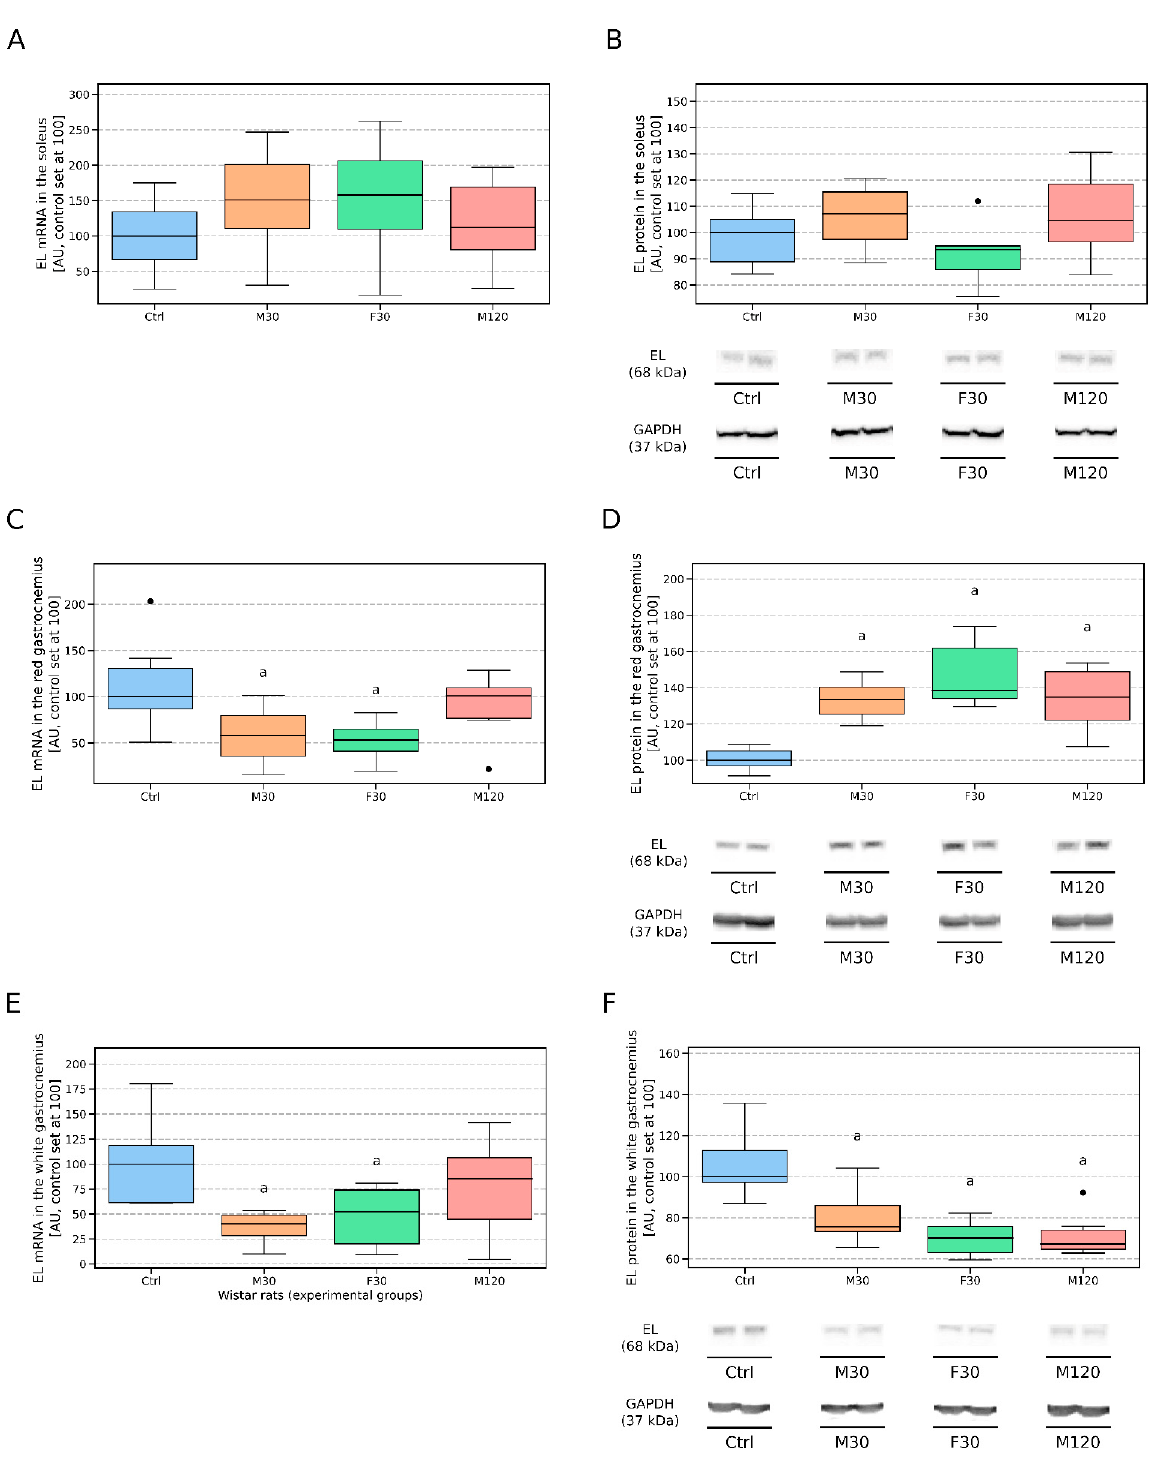
Figure 3. Endothelial lipase (EL) gene and protein expression in the vascular beds of the soleus ( A , B ), the red gastrocnemius muscle ( C , D ) and the white gastrocnemius muscle ( E , F ) in response to a treadmill run. The inner horizontal line of a box represents the median. Box boundaries: 25–75 percentile, Box whiskers: 1.5 interquartile range or max/min value in the group. Solid black dot—data point laying outside 1.5 * IQR (the interquartile range). Representative Western blots images are shown. a—difference vs. control (Ctrl), p < 0.05; b—difference F30 vs. M30, p < 0.05; c—difference M120 vs. M30, p < 0.05, n = 6 per group, RT-PCR assessments were performed in duplicates. Ctrl—control, M30—moderately intense run (speed: 18 [m/min], duration: 30 [min]), F30—fast run (speed: 28 [m/min], duration: 30 [min]), M120—moderately intense run (speed: 18 [m/min], duration: 120 [min]).